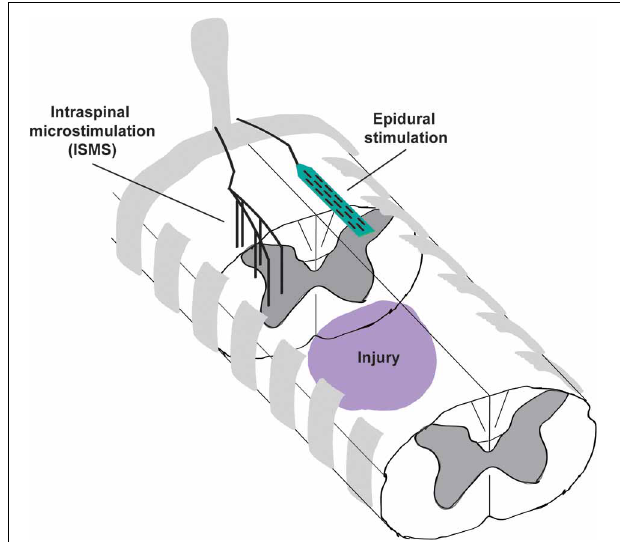
FIGURE 1 | Schematic illustrating the placement of intraspinal microstimulation (ISMS) electrodes and epidural stimulation electrodes caudal to a spinal cord injury. ISMS electrodes penetrate the spinal cord to target the intermediate and ventral gray matter for activation of local spinal circuits. Epidural stimulation electrodes reside on the dorsal surface of the spinal cord, most likely activating the dorsal root entry zones or dorsal